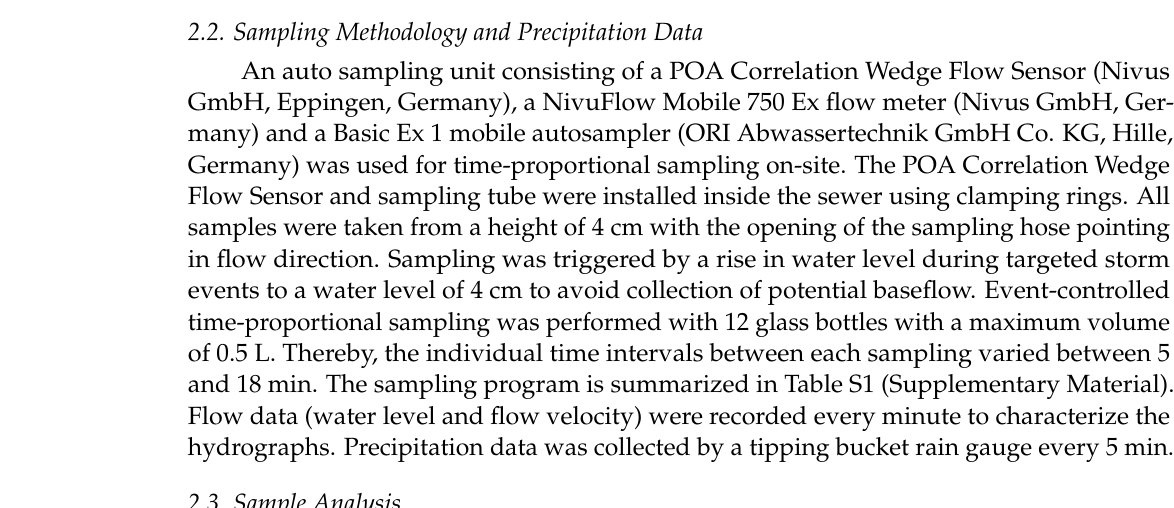
Table 2. Catchment characteristics of the studied residential catchment in Braunschweig, Germany. Total Catchment Size Max. Distance Channel Diameter Catchment Location (Total Imperviousness) Catchment 1 @ Sampling Site Type 1 [ha] [m] [mm] Braunschweig/Germany Residential 5 (1.8)